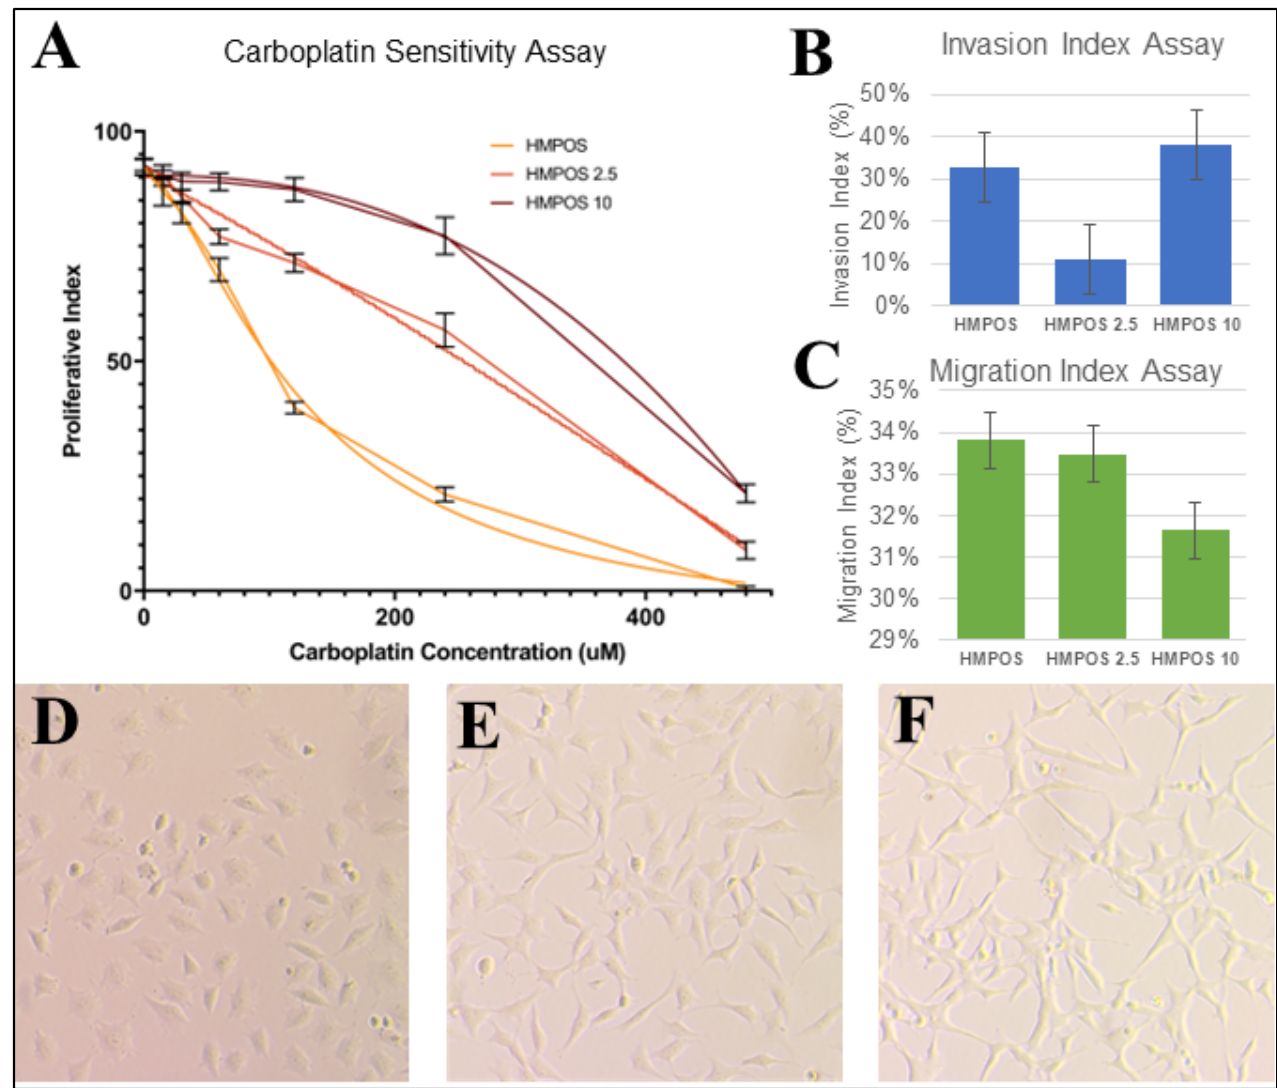
Figure 2. ( A ) Proliferative index for each HMPOS cell line at carboplatin dosages of 0 μ M, 15 μ M, 30 μ M, 60 μ M, 120 μ M, 240 μ M, and 480 μ M. Three technical replicates of three biological replicates are shown. Nonlinear regression curve for resistance to carboplatin is significant according to the extra sum-of-squares F ( p < 0.001). ( B ) Average % of Invasion Index Assay; the p -value was significant and found to be 0.00013753 using an ANOVA single-factor test. However, the Tukey’s HSD p -values between HMPOS and HMPOS-2.5 and between HMPOS-2.5 and HMPOS-10 were 0.001 and 0.001 respectively, while it was 0.379 between HMPOS and HMPOS-10. ( C ) Average % of Migration Index Assay; the p -value was not significant and found to be 0.06012698 using an ANOVA single-factor test. Light microscopy photos of ( D ) HMPOS, ( E ) HMPOS-2.5, and ( F ) HMPOS-10 showing distinct phenotypic differences, from cuboidal to spindle morphology.